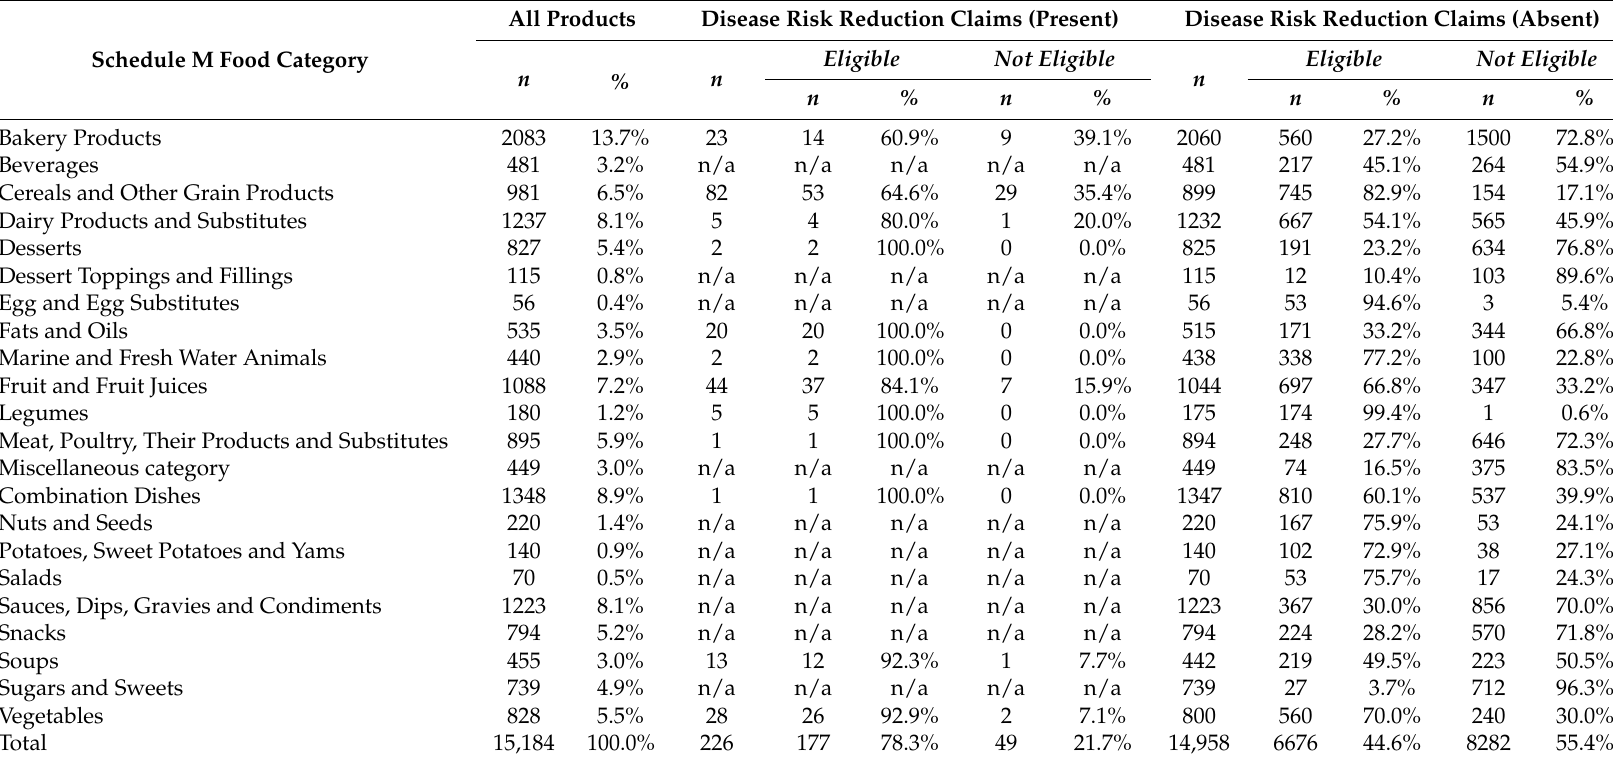
Table 3. Proportion of foods and beverages carrying disease risk reduction claims that would or would not be eligible to carry such claims according to the FSANZ-NPSC, by Schedule M food category ( n =